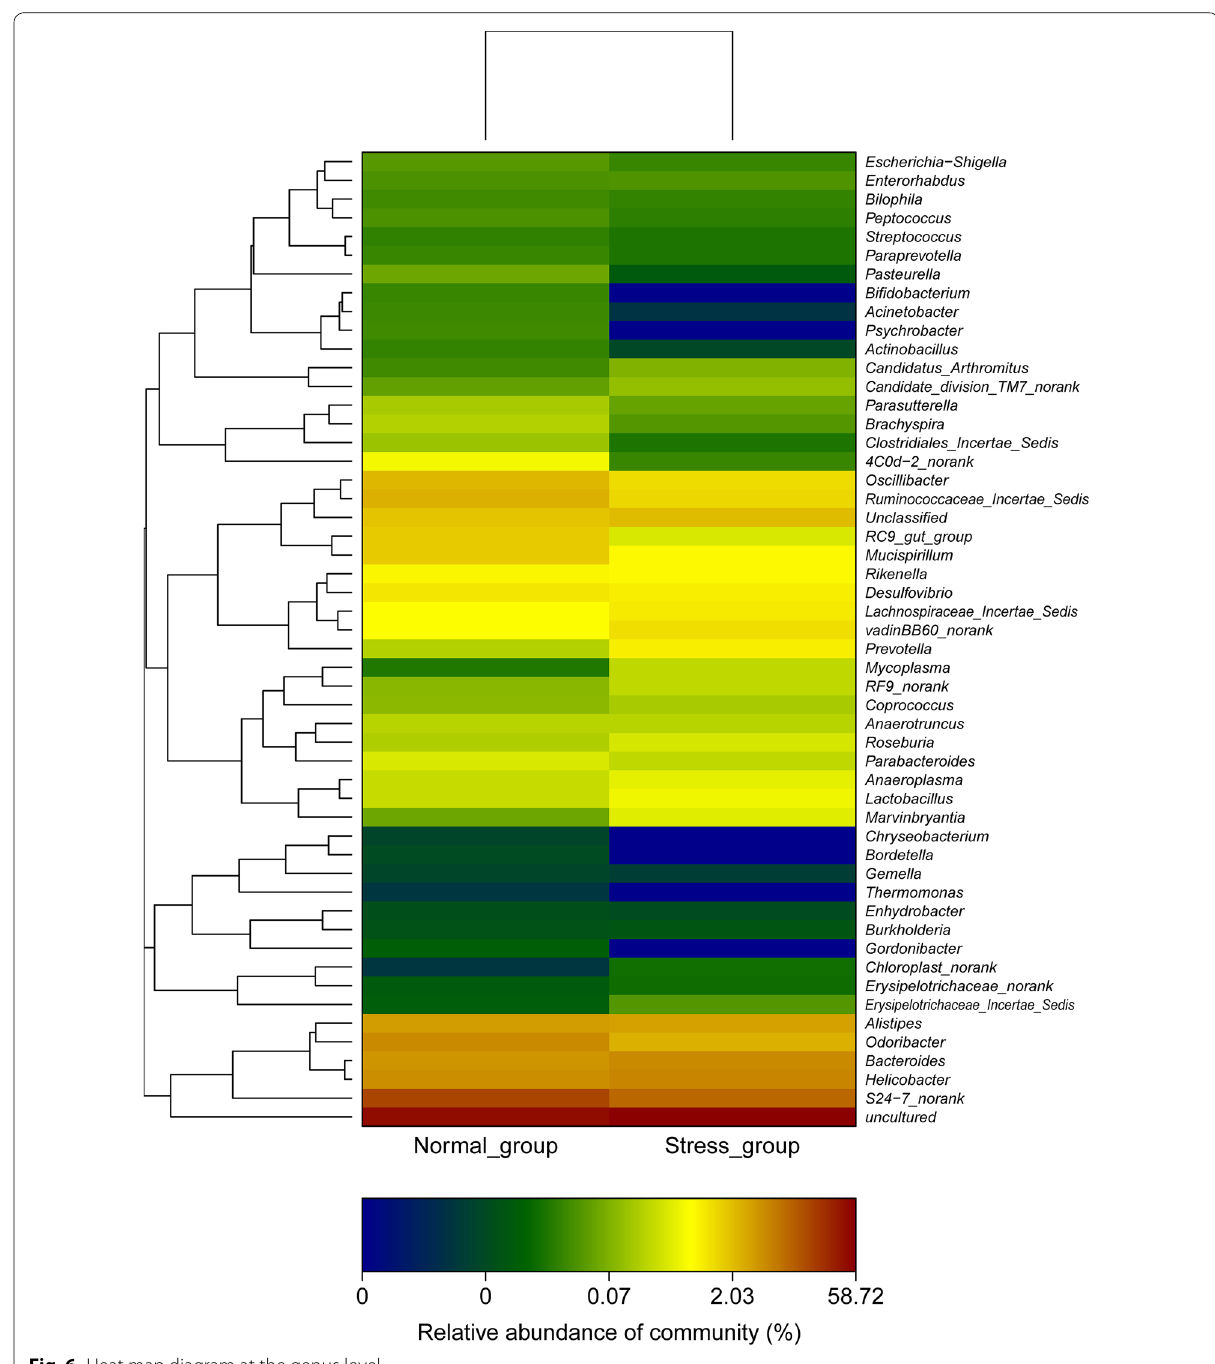
Fig. 6 Heat map diagram at the genus